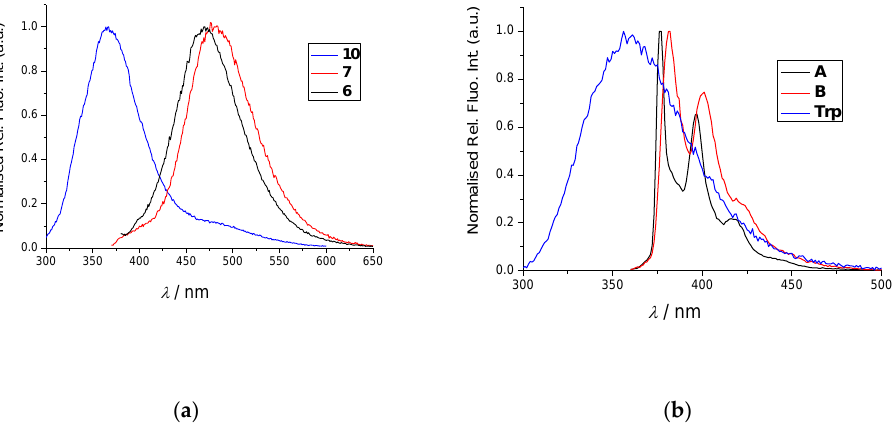
Figure 2. ( a ) Normalised fluorescence spectra of the studied peptides 6 ( λ exc = 352 nm), 7 ( λ exc = 350 nm) and 10 ( λ exc = 295 nm) in water (0.01% DMSO); ( b ) Normalised fluorescence spectra of the referent compounds 1-pyrenebutyric acid ( A , λ exc = 342 nm), pyrenecarboxylic acid ( B , λ exc = 341 nm) and tryptophan ( Trp , λ exc = 295 nm), in water. Normalisation was performed by dividing the complete spectrum by the maximal intensity of emission.